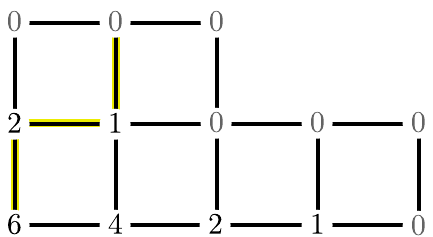
Figure 8 . The Young diagram for M = 6, K = 2. The number on each node denotes the degree of the Q